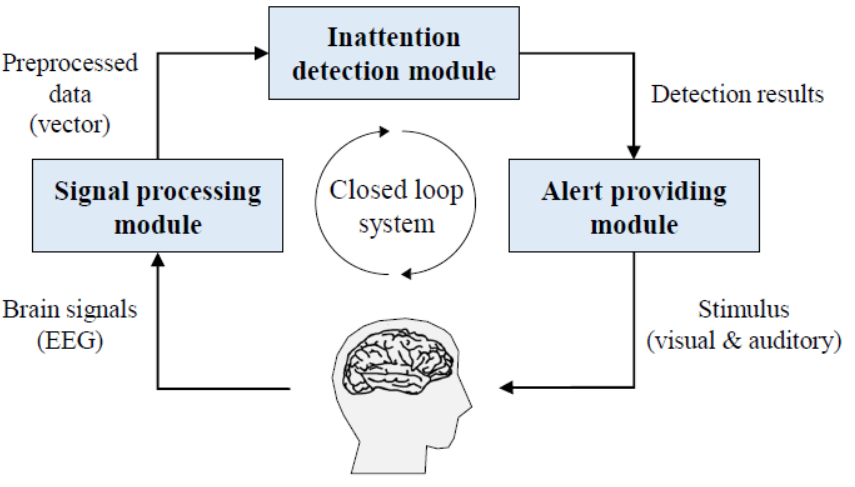
Figure 4. EEG-based Brian Computer Interaction Process (BCI) to collect human meotion